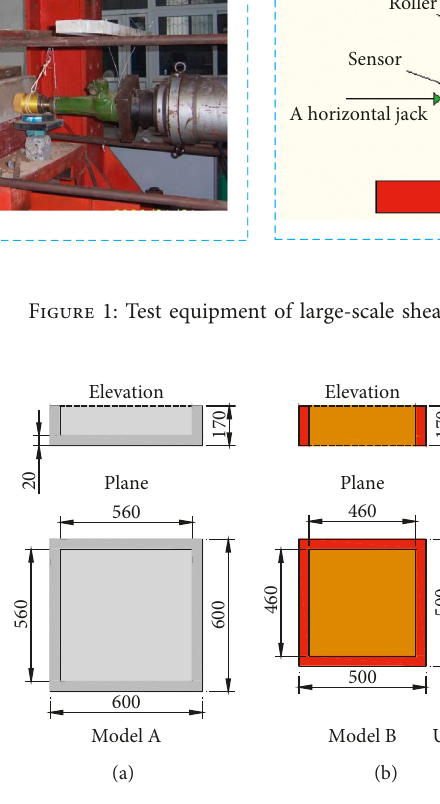
Figure 2: Model dimensions.